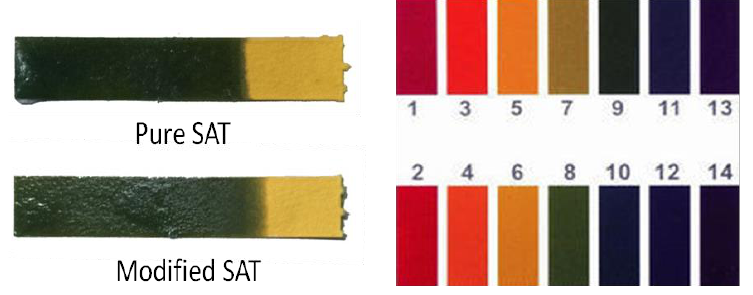
Figure 10. pH values of the pure SAT and modified SAT.